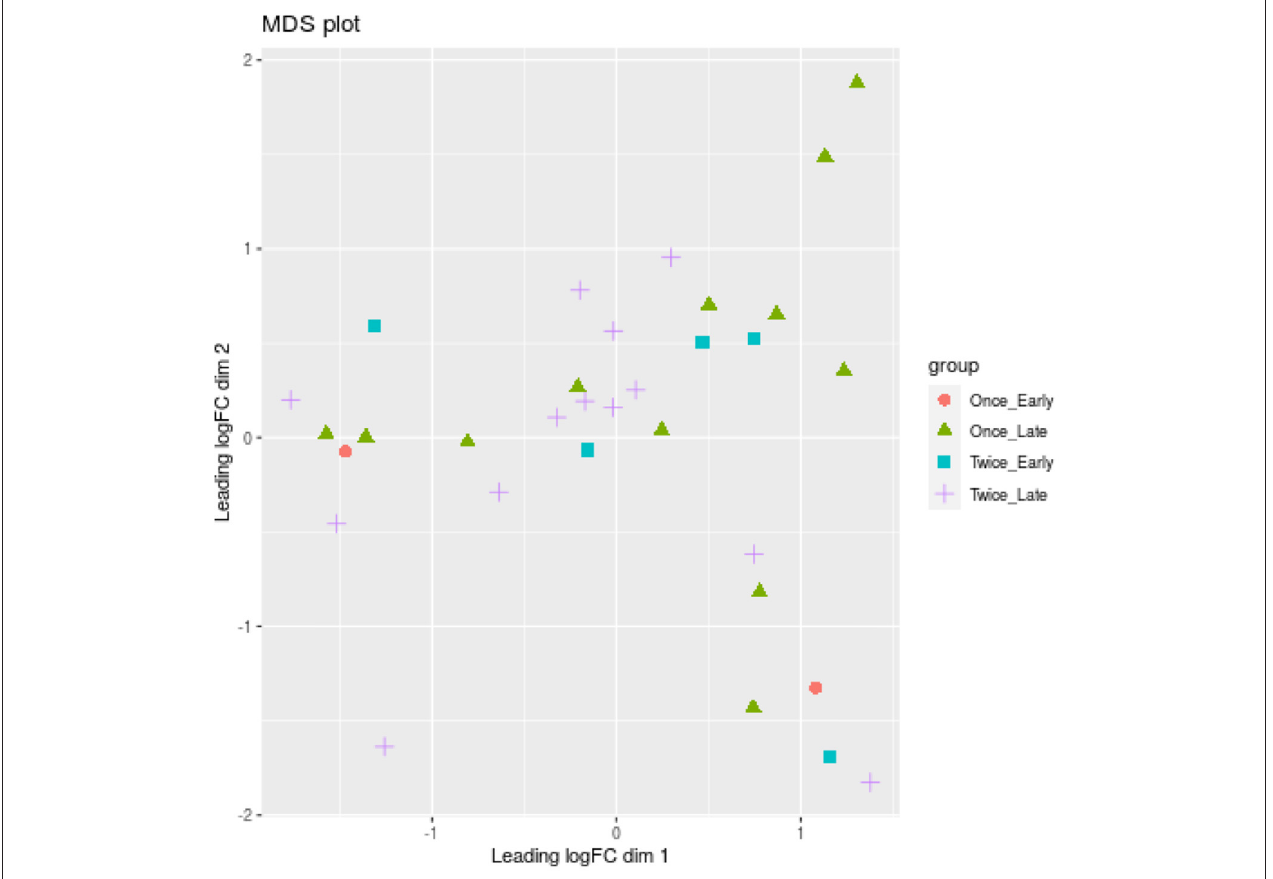
FIGURE 4 | Multidimensional scaling (MDS) plot based on all methylation sites. Each dot represents a ewe sample and is colored by the pregnancy duration (early vs. late) and shearing treatment (once vs. twice). Only the 50 most significant loci ( p < 0.05) were used for the MDS